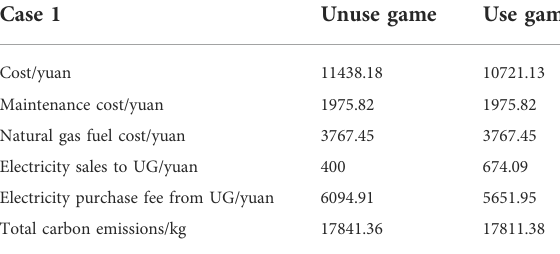
TABLE 2 Case 1: comparison of cost using the Stackelberg